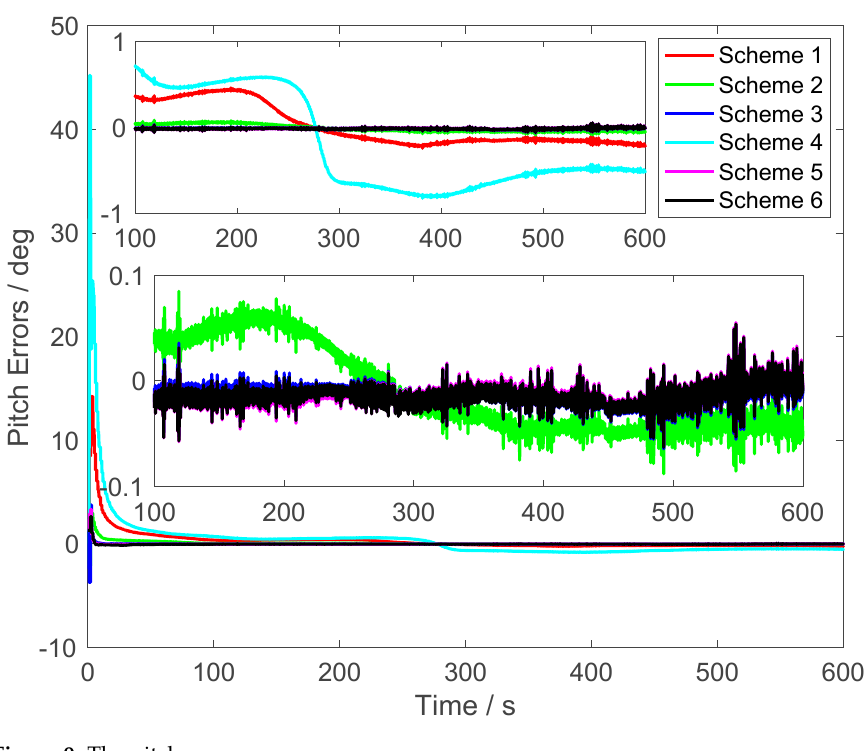
Figure 9. The pitch errors.